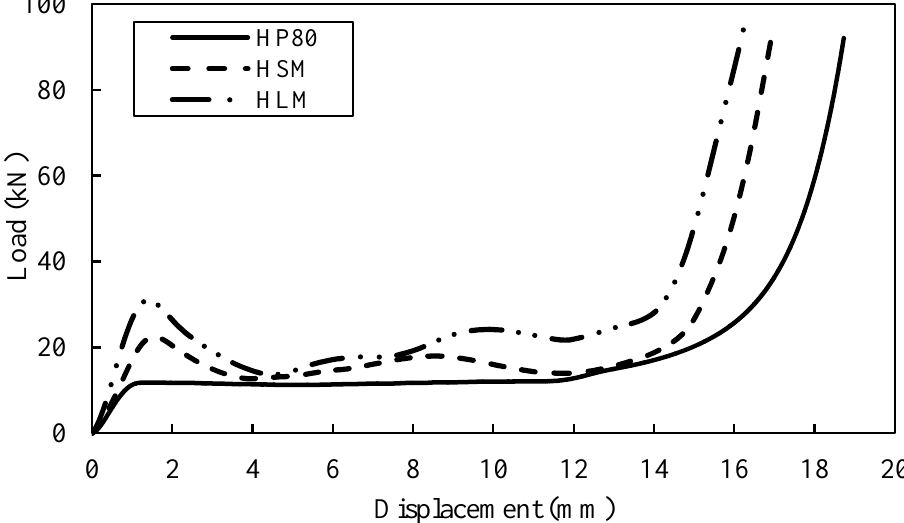
Figure 11. Load-displacement curve for multiple tube reinforced with HP80 foam structure. Furthermore, the SEA value and strength found to be increased when there is an increasing in tube diameter as well as the foam density. This shows that the local limitation imposed by the F50 and HP80 foam has a significant impact on the failure processes in tubes. In Figure 13, the deformation failure of multiple tube reinforced foam structures after testing is presented. The top section of the PVC tube shift slightly to one side when interpenetration occurred due to the transverse shear while the fracture of fibre occurred in the bamboo tube causes the tube to fractured into radial cracks and longitudinal splitting [7,17]. The failure of the bamboo tube can be seen clearly from the top view. As comparison to the Figure 9a, the failure of the single bamboo tube reinforced foam structure (FBS) is similar to the multiple bamboo tube reinforced foam structure (FBM) as shown in Figure 13a. The failed bamboo tube pushed the foam and leads to a crack in the foam structure. This means that the neighbouring tube properties can be affected as well. Figure 13 compares the single and multiple tubes reinforced foam